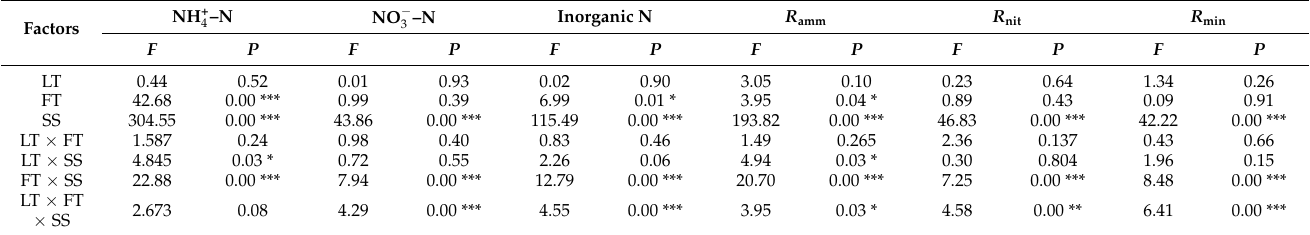
Table 1. Repeated-measures ANOVA results for the effects of sampling season (SS), litter treatment (LT), forest type (FT), and their interactions on the soil ammonium (NH + inorganic N concentration, and ammonification ( R amm ), nitrification ( R nit ) and N mineralization ( R min ) rates.